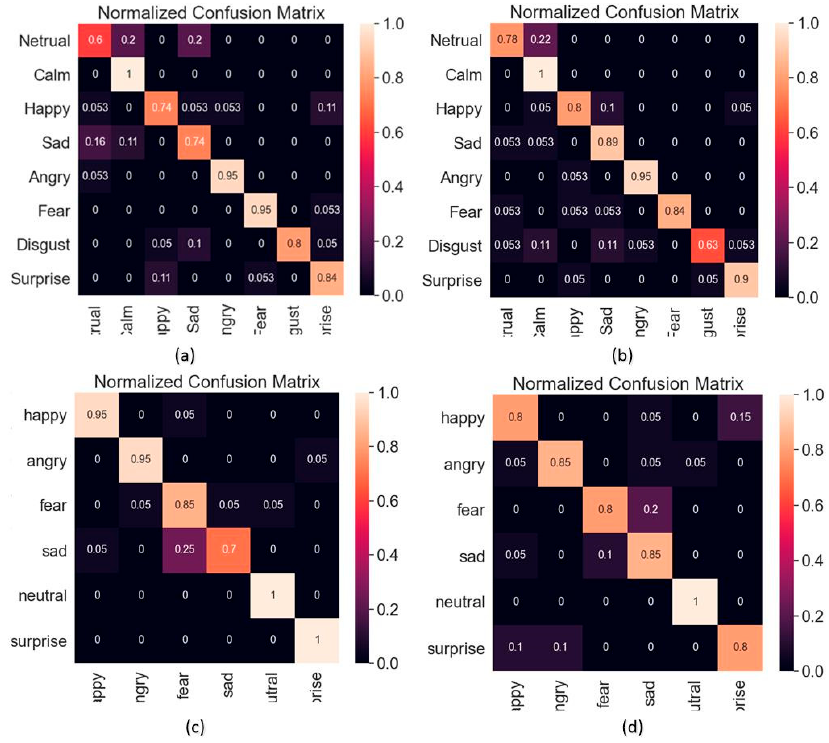
Figure 5. CNN recognition results. ( a ) Result of male speech in RAVDESS dataset. ( b ) Result of female speech in RAVDESS dataset. ( c ) Result of male speech in CASIA dataset. ( d ) Result of female speech in CASIA dataset.